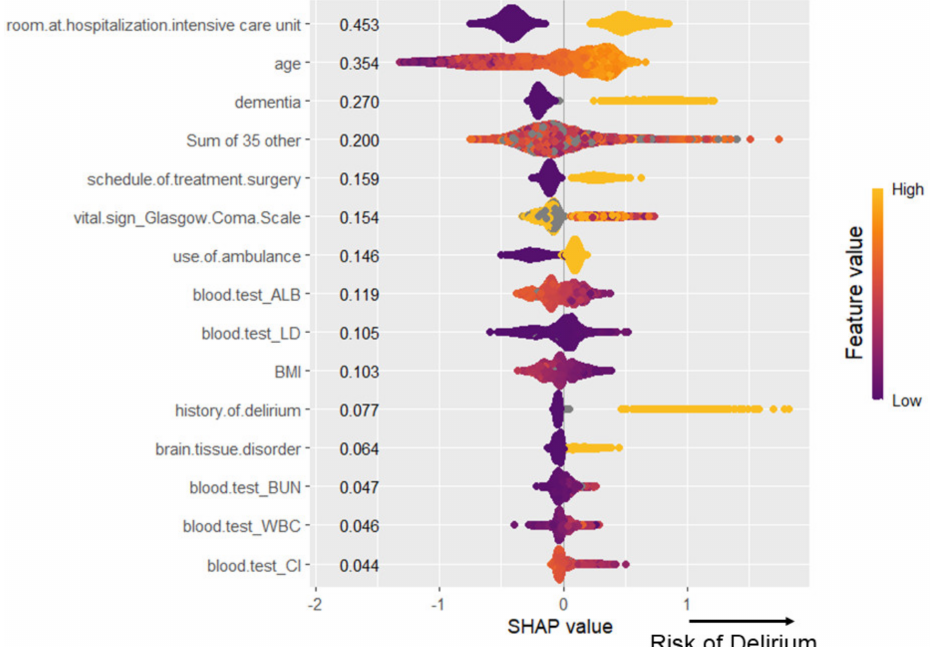
Figure 3. SHAP summary plot for Population B. SHAP summary plot of a 44-predictor XGBoost model. Each dot denotes a patient. Although there are 44 predictors, the one-hot encoding process results in 49 features when inputting into the XGBoost model. The top 15 predictive contributing features are shown. The x-axis shows the SHAP value attributed to the predictors. Higher SHAP values represent higher risk of delirium due to predictors.